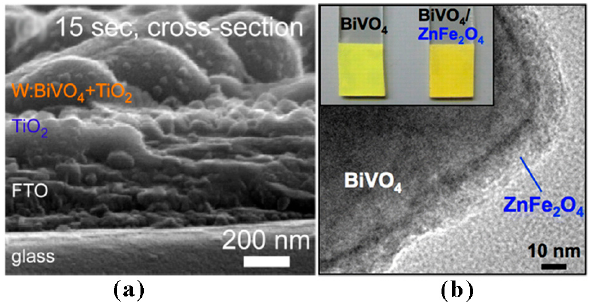
Figure 5. Passivation layers in BiVO 4 photoanodes: ( a ) thin amorphous TiO 2 , reprinted with permission from [86]. Copyright American Chemical Society, 2014; ( b ) ZnFe 2 O 4 , reprinted with permission from [88]. Copyright American Chemical Society,